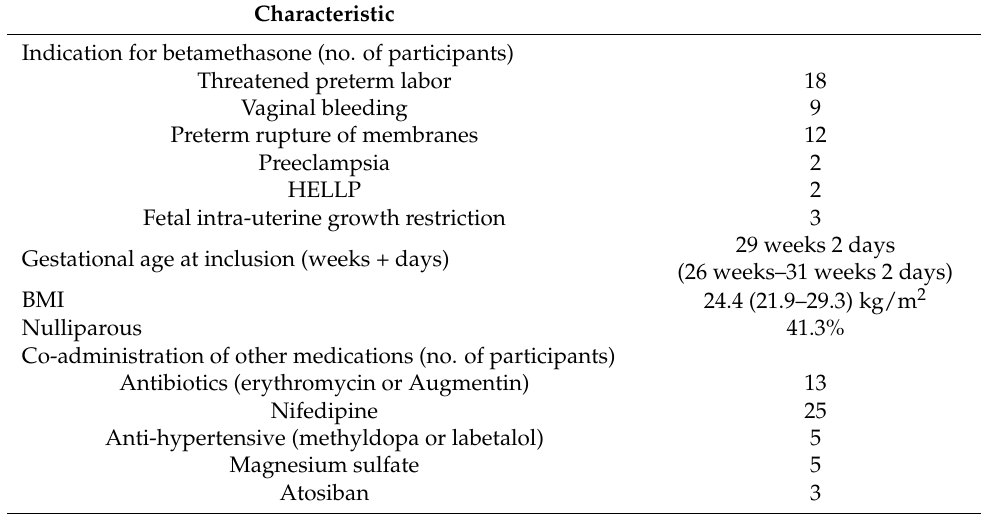
Table 1. Patient characteristics presented as occurrence or median and interquartile range, as appropriate.